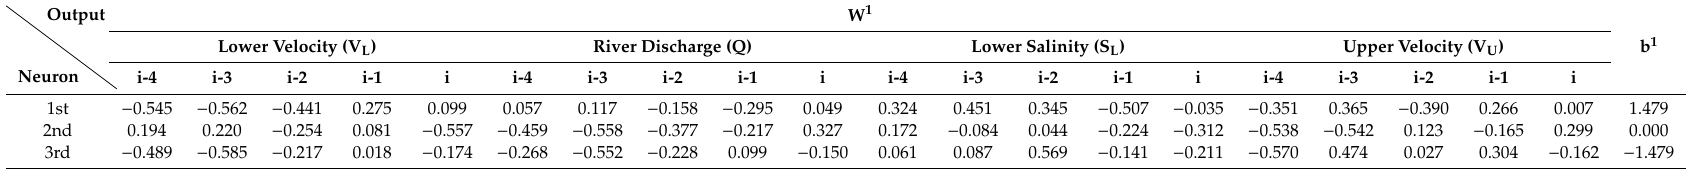
Table A1. Weight(W 1 ) and bias(b 1 ) matrix of hidden layer (Case: QV L S L S U and Subset 5). The superscript 1 indicates the hidden layer.